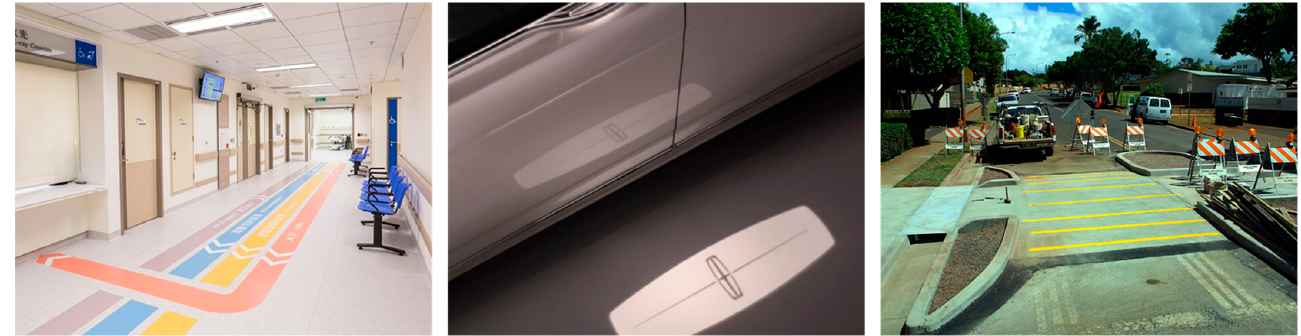
Figure 2. ( Left to right ) Tin Shiu Wai Hospital floor wayfinding [17], Lincoln Welcome Lighting [18], and a raised crosswalk [19].